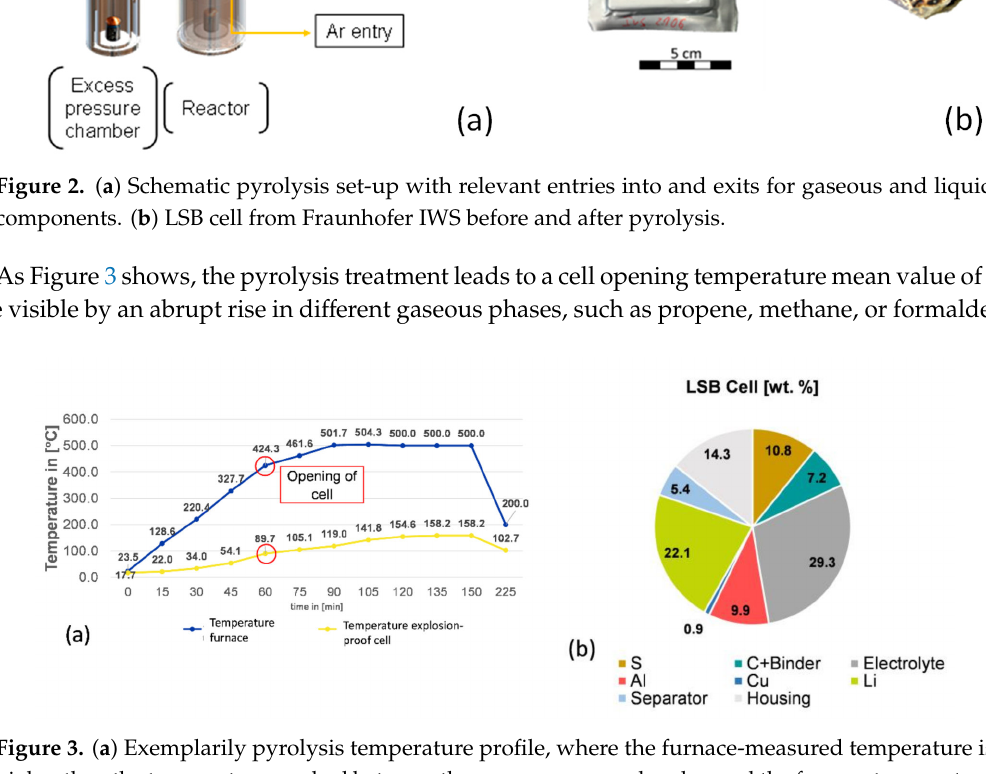
Figure 3. ( a ) Exemplarily pyrolysis temperature profile, where the furnace-measured temperature is higher than the temperature reached between the excess pressure chamber and the furnace temperature. ( b ) Exemplarily composition of an LSB 1 cell, whose chemical composition changes due to pyrolysis in terms of removing up to 5.4 wt.% from the separator, 29.3 wt.% from the electrolyte, and maximum 7.2 wt.% from binder .